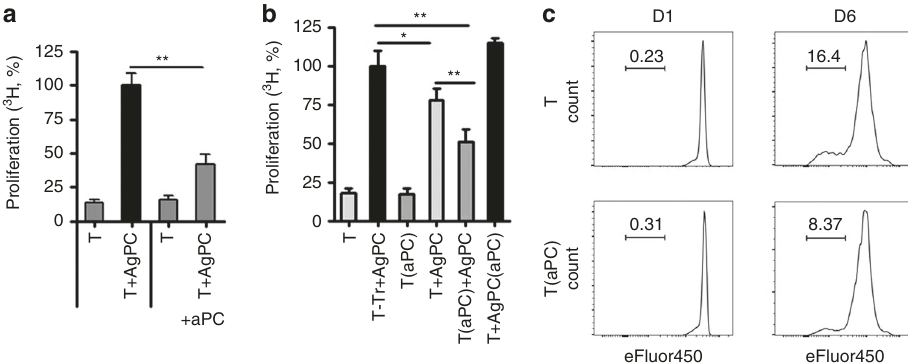
Fig. 2 T-cell preincubation with aPC reduces allogenic T-cell reactivity and proliferation. a Splenic T-cells isolated from C57BL/6 wild-type ( wt ) mice (T) were co-cultured with BALB/c allogenic antigen-presenting cells ( AgPC ) for 96 h and T-cell reactivity was measured by thymidine incorporation during the fi nal 16 h. Concomitant incubation with aPC ( a +aPC, 20 nM, every 12 h) reduces T-cell reactivity. b aPC-preincubation (20 nM, 1 h, 37 °C) of mouse pan T-cells (T(aPC) + AgPC), but not of mouse AgPC (T + AgPC(aPC)), reduces T-cell reactivity in the MLR in comparison to T reg -depleted T-cells (T-Tr + AgPC) and T-cells (T + AgPC). c Mouse pan T-cells without (T) and with (T(aPC)) aPC-preincubation were labelled with eFluor450 and then stimulated with plate bound α CD3 (1 µ g/ml) and α CD28 (0.5 µ g/ml) antibodies and proliferation was measured on day 1 ( D1 ) and day 6 ( D6 ) by FACS. Results of at least three independent experiments, each containing cells from three different mice a , b are shown; representative histogram plots c from triplicate wells of three independent experiments are shown. Mean value ± SEM a , b ; *P < 0.05, ** P < 0.01 ( a t -test, b